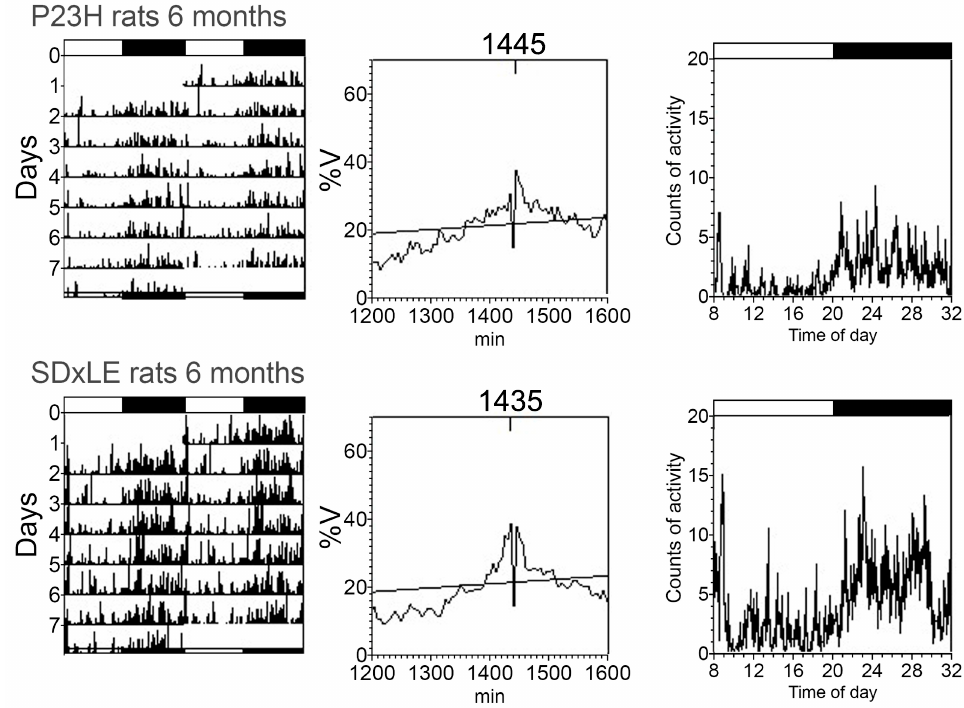
Figure 4. Representative actograms (left), periodograms (middle), and mean waveforms (right) obtained analyzing locomotor activity rhythms at P180 in P23H and SD × LE rats without treatment. The light/dark cycle is represented by white and dark horizontal bars, respectively.